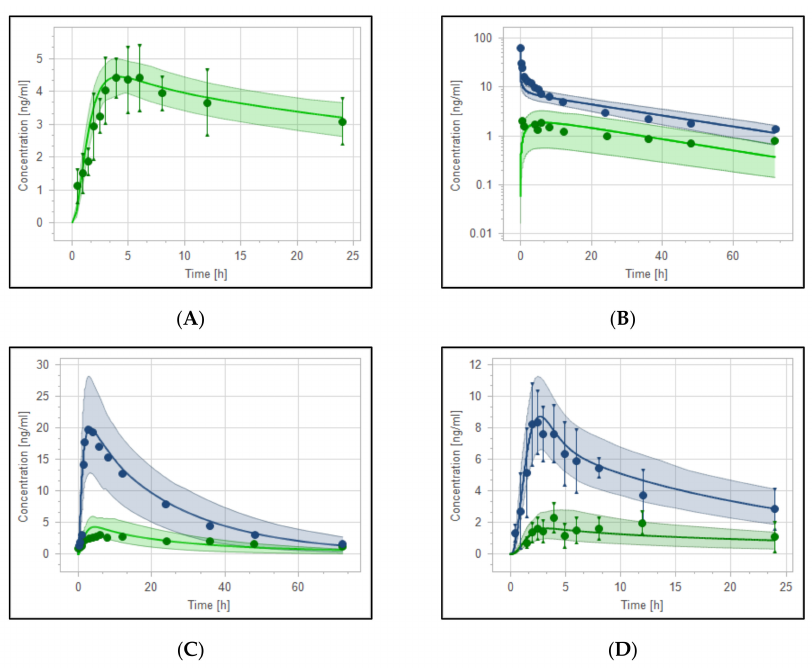
Figure 5. Plasma-concentration time curves of haloperidol (blue) and reduced haloperidol metabolite (green). ( A ) Simulated and observed data of 10 mg reduced haloperidol administered orally [48]. ( B – D ) Haloperidol (blue) and reduced haloperidol (green) after 0.125 mg/kg IV [42], 0.5 mg/kg oral [42], and 10 mg oral haloperidol [48], respectively. Observed data are depicted as circles and means of simulations are depicted as solid lines with the 5th–95th predictive range being depicted as shaded areas.